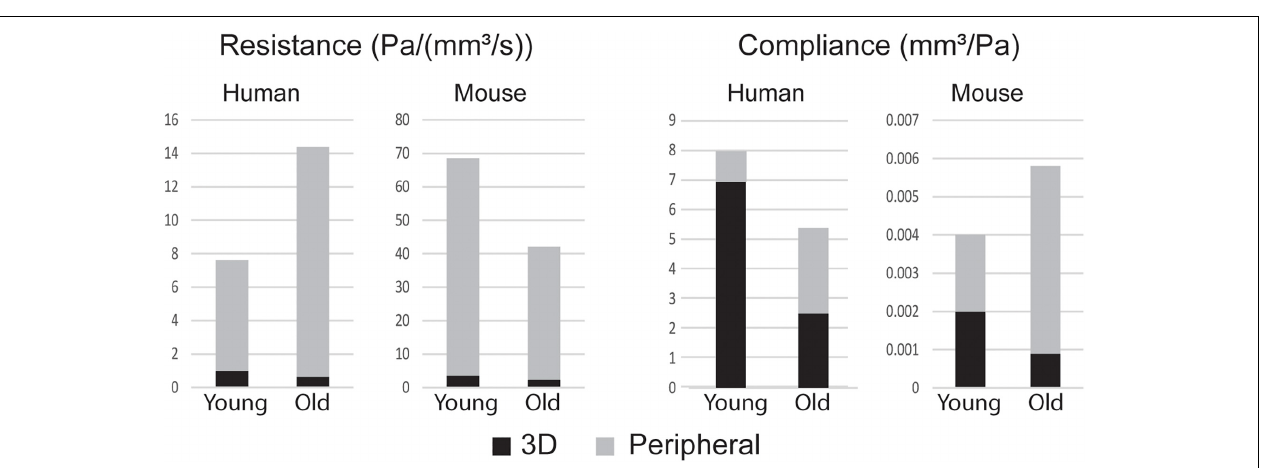
FIGURE 5 | Total resistance R TOT and compliance C TOT broken into components of the central (3D) and peripheral